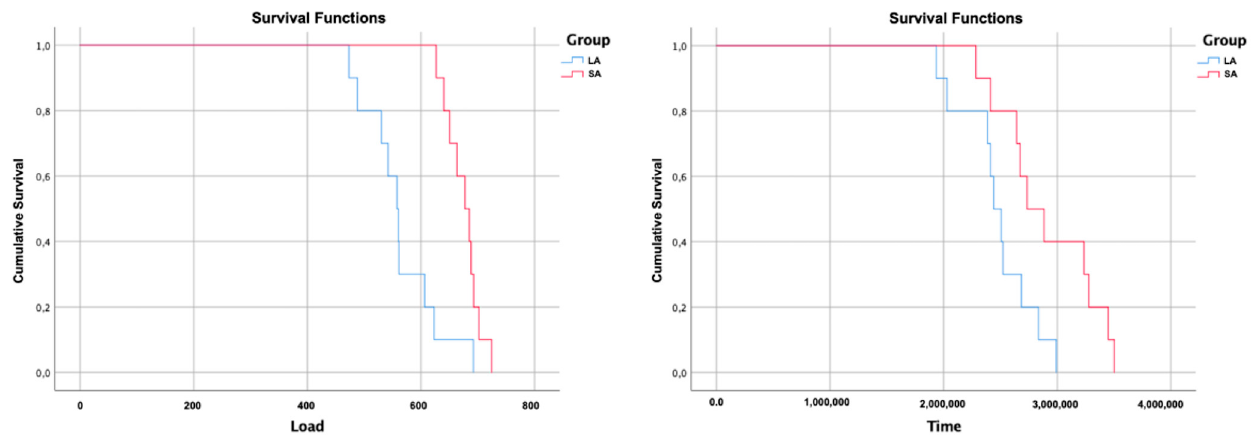
Figure 6. Survival graph of groups as a function of load (N) and time (cycles). Legend: Survival profile between SA (short abutment) and LA (long abutment) groups. As a function of load and time per number of cycles, until failure of the implant/abutment set.